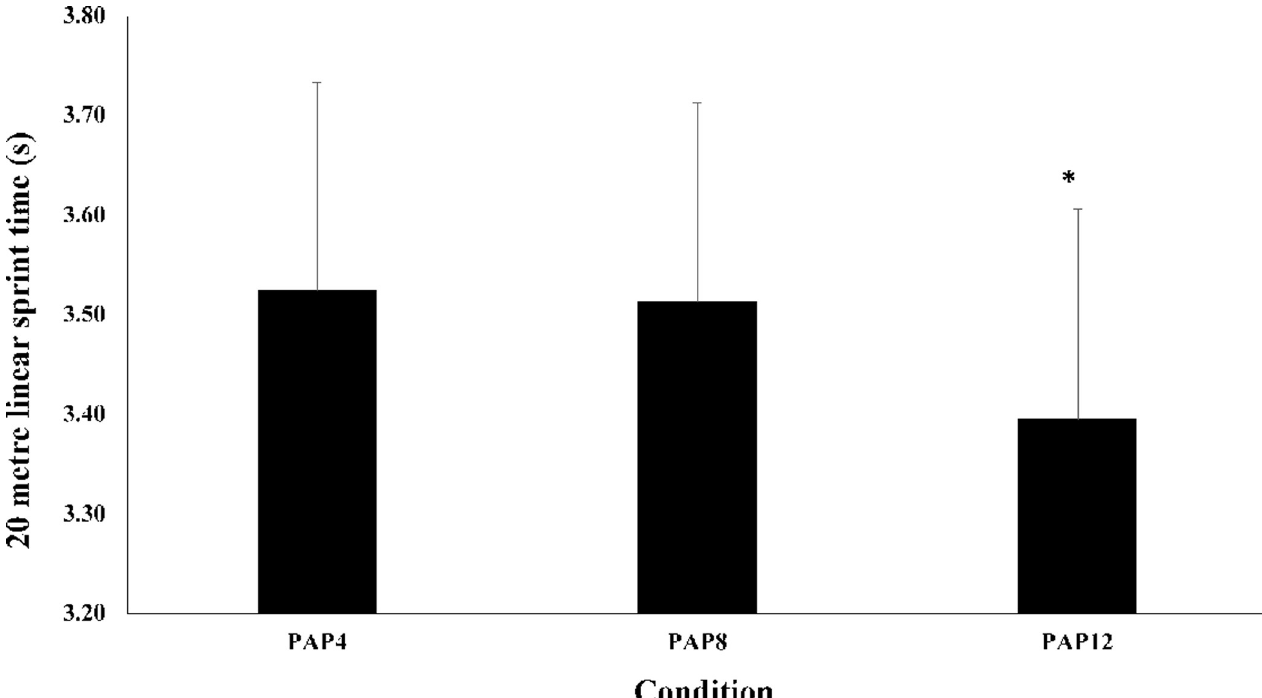
Fig 3. Mean ± SD for 20-m linear sprint times (s) for the PAP 4, PAP 8 and PAP 12 conditions. � Denotes a statistical significance compared to other conditions ( P < 0.0005).